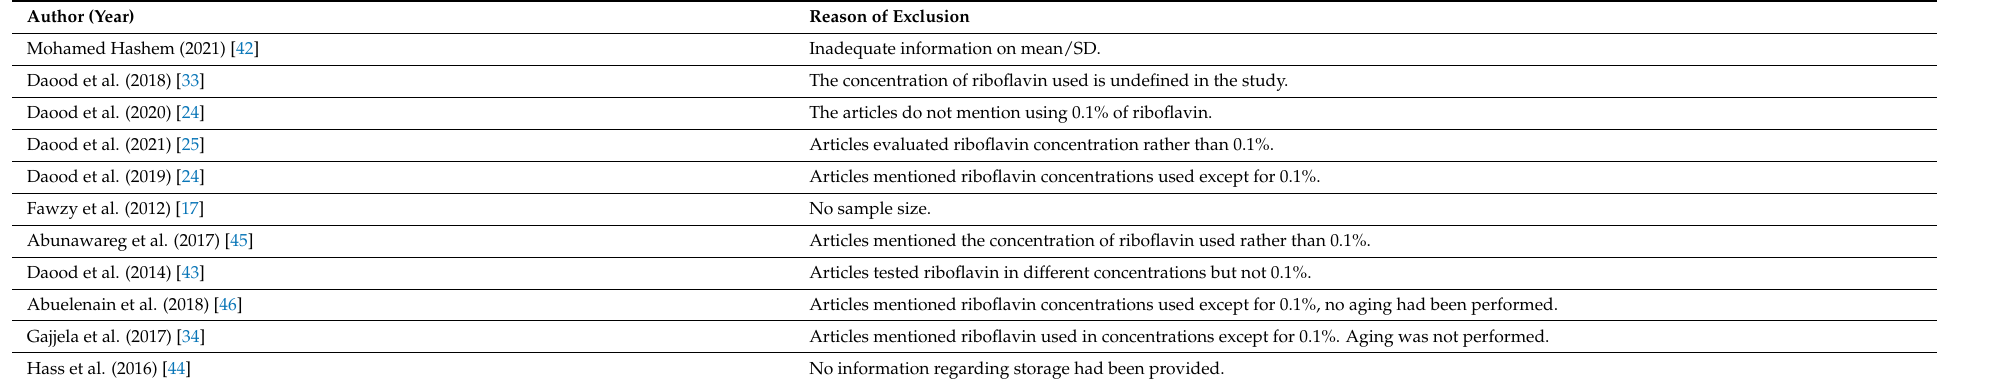
Table 3. List of excluded papers from meta-analysis and systematic data extraction